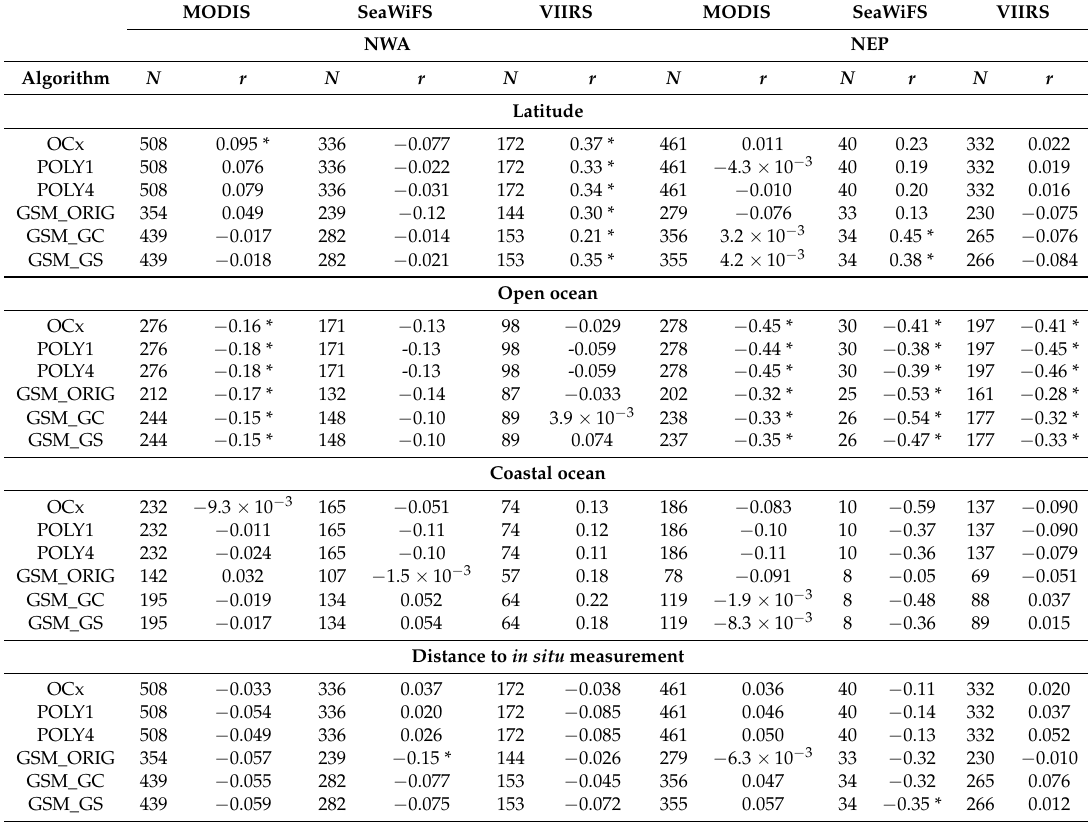
Table 7. Pearson’s correlation coefficients ( r ) for the test for correlation between | E chla | and geographic environmental factors (see Section 2.6). * = statistically significant ( p -value <